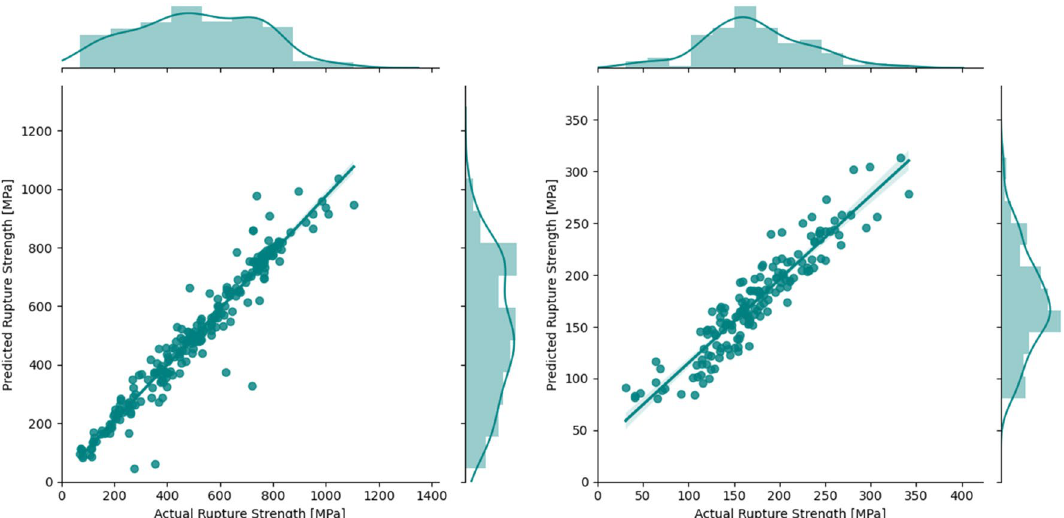
Figure 3. Parity plot for the testing data for NN regression for the 9–12% Cr FMA (left) and austenitic stainless steels